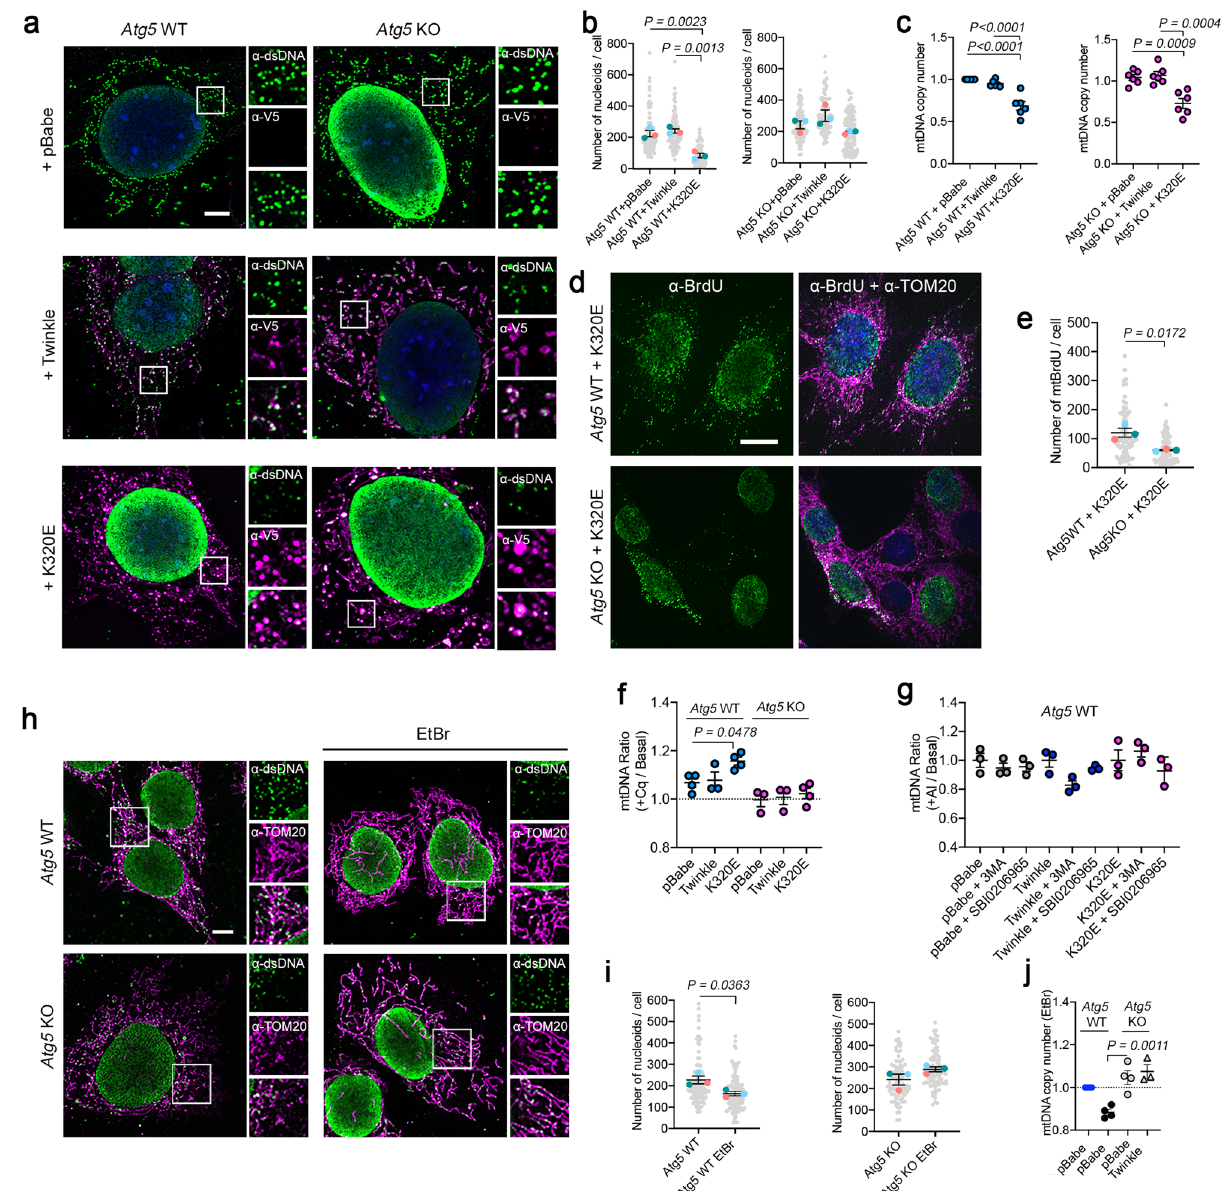
Fig. 3 | ATG5 is required for mtDNA clearance after mtDNA damage. Atg5 WT and KOcellswere transduced with Twinkle-APEX2-V5plasmids. a α -DNA and α -V5- tag immuno fl uorescence con fi rming localization of Twinkle in mtDNA nucleoids. b Quanti fi cation of mtDNA foci number in Atg5 WT and Atg5 KO cells ( n =3, >25 cells per experiment). ( c ) Steady state mtDNA copy number in Atg5 cells ( n =6 independent cultures). d , e α -BrdU and α -TOM20 immuno fl uorescence and quanti fi cation of mtDNA replication foci detected by treating the cells for 6h with 20 µ MBrdU.( n =3,>20cellsperreplicate). f Quanti fi